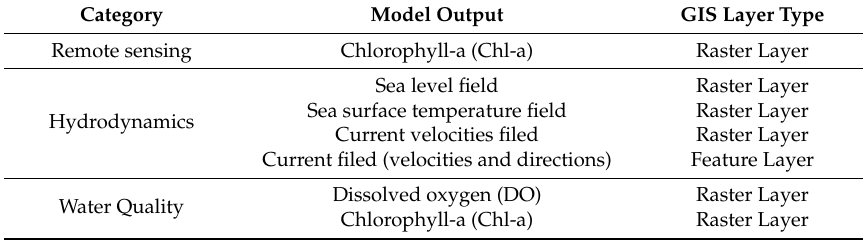
Table 1. The model output variables and corresponding Geographic Information System (GIS)